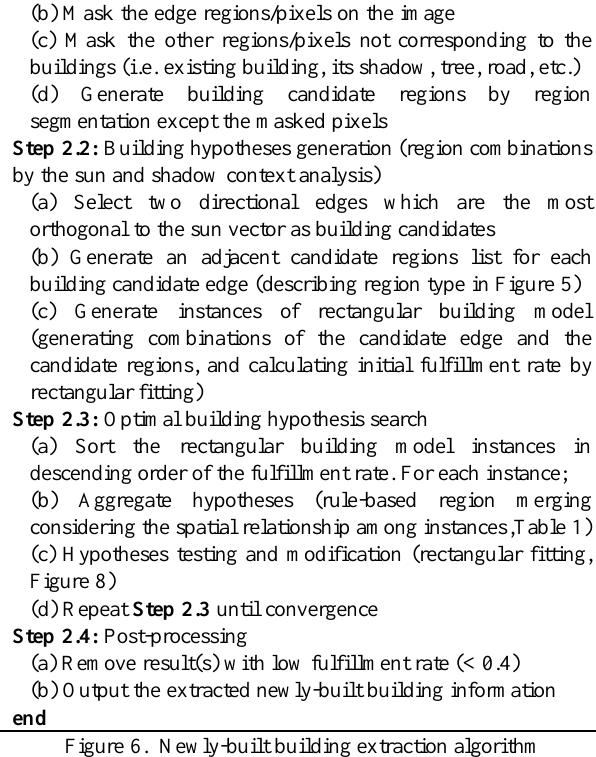
Figure 6. Newly-built building extraction